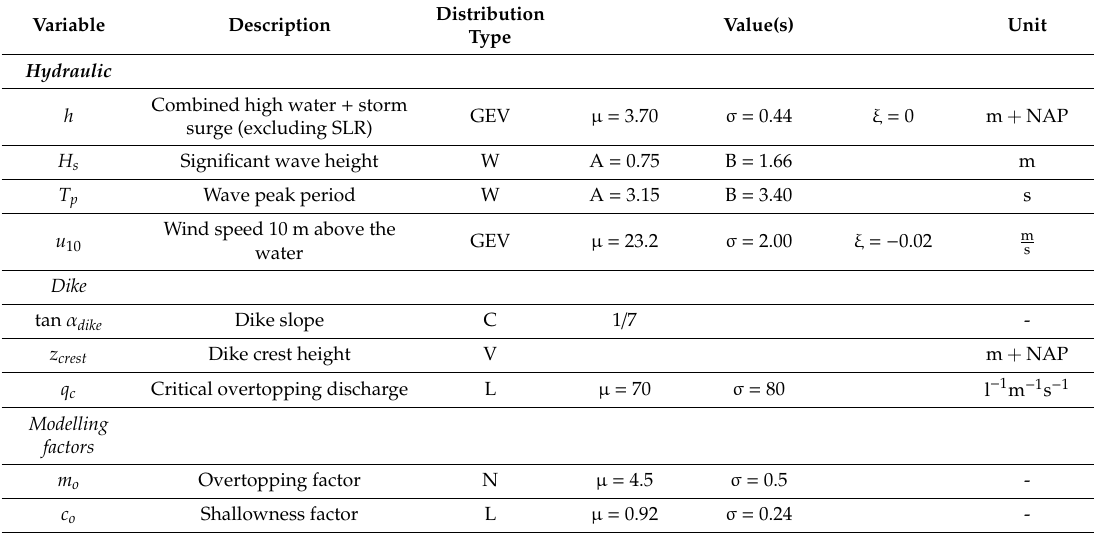
Table A3. Parameters used in the dike reinforcement calculation. Distributions are GEV = generalized